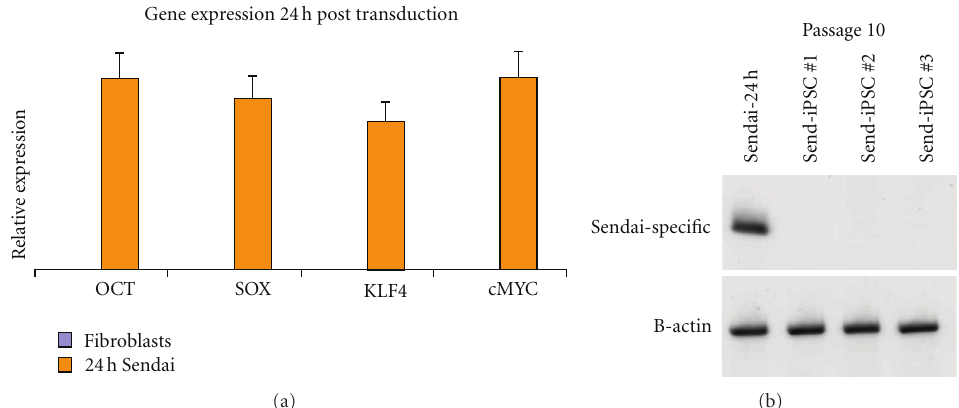
Figure 6: (a) Detection of viral gene expression at 24 hours after transduction with Sendai virus vector by TaqMan Gene Expression Assays. (b) Detection of virus-free iPSCs after 10 passages in culture by end-point PCR.